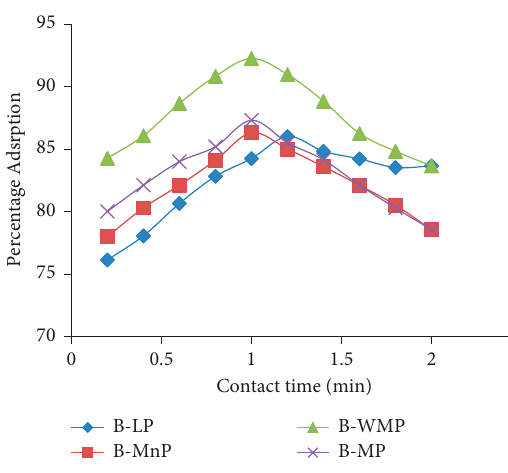
Figure 5: Effect of contact time of different sorbents on the sorption of Cr (VI).